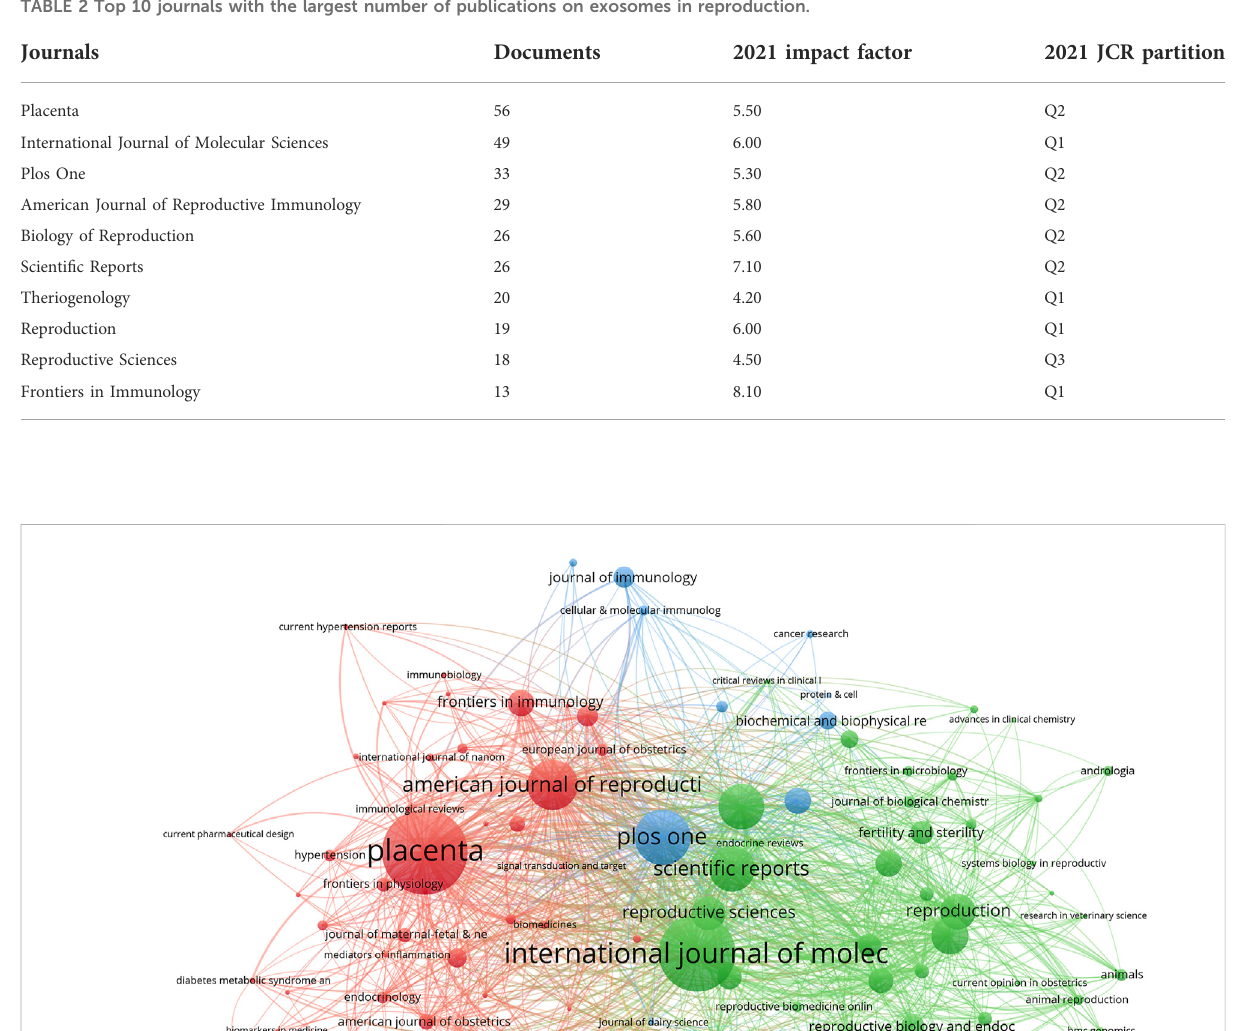
TABLE 2 Top 10 journals with the largest number of publications on exosomes in reproduction.